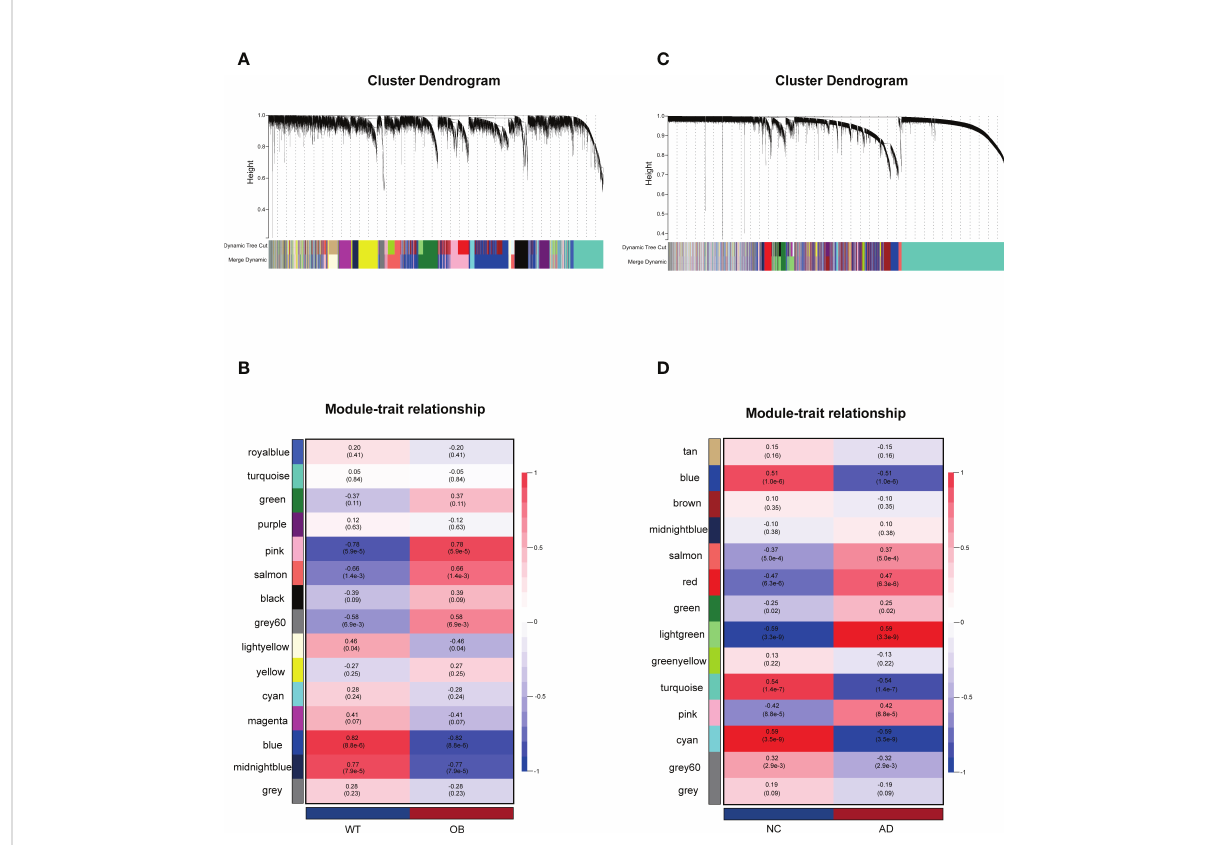
FIGURE 1 Weighted gene co-expression network analysis (WGCNA). (A) The Gene clustering tree (dendrogram) in OB. (B) Module – trait relationships in OB. Each cell contains the corresponding correlation and p -value. (C) The Gene clustering tree (dendrogram) in AD. (D) Module – trait relationships in AD. Each cell contains the corresponding correlation and p -value. OB, obesity; AD, Alzheimer ’ s